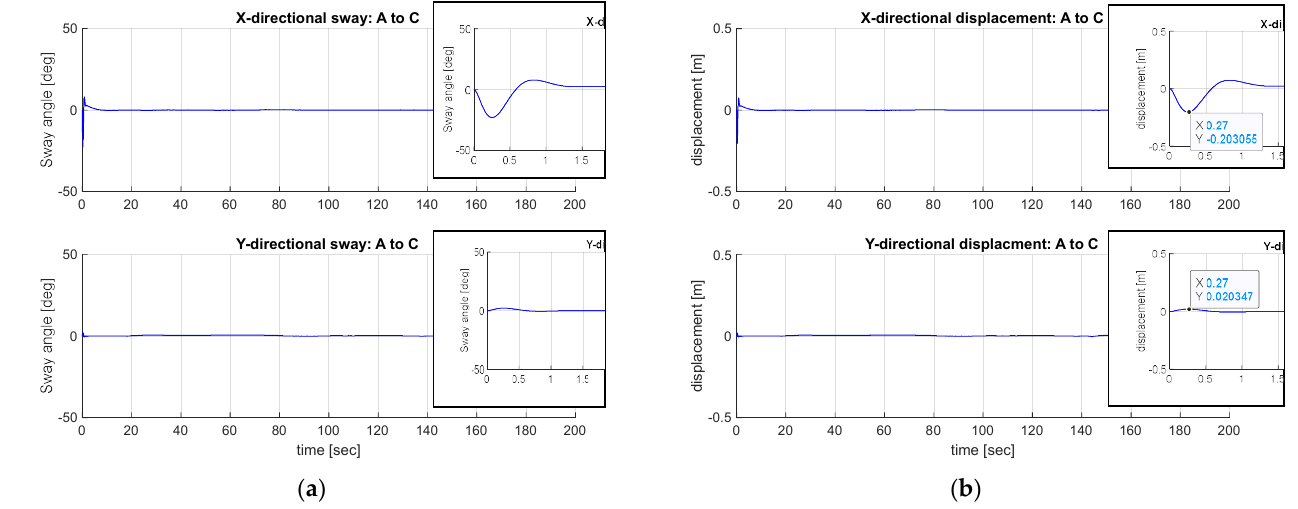
Figure 22. Motion control performance. ( a ) Sway angle reduction in x/y direction. ( b ) Displacement of the patient in x/y direction.